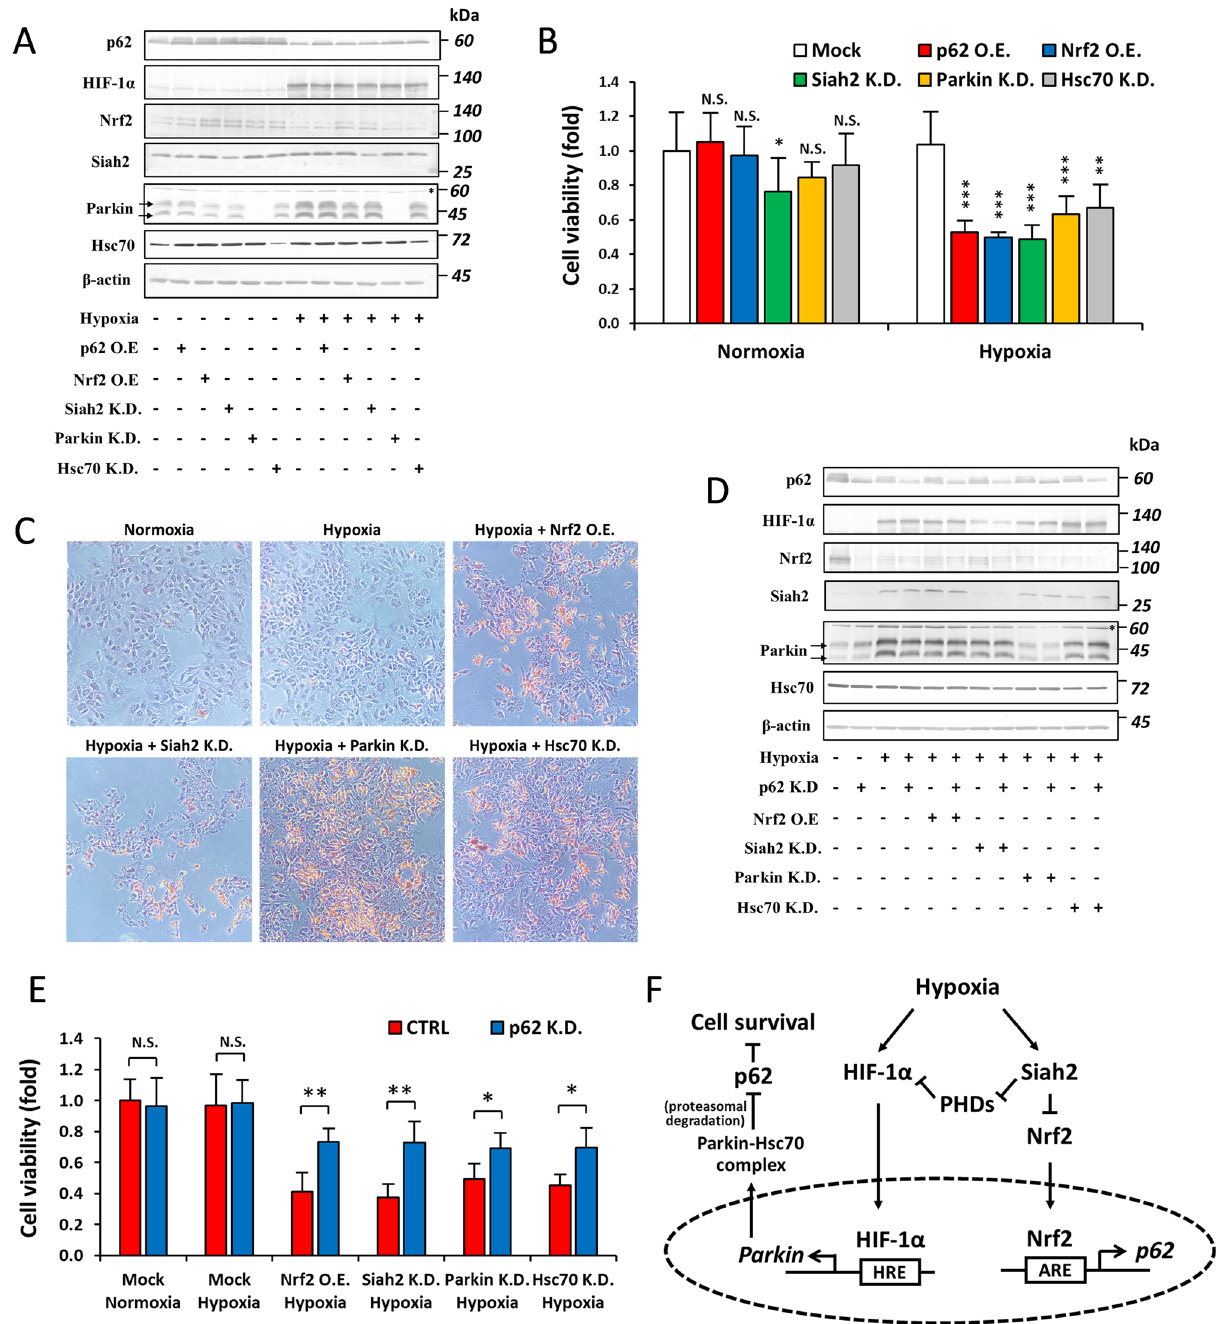
Figure 6. p62 depletion under hypoxia is essential for cell survival . ( A – C ) Hep3B cells were transfected with pcDNA-p62 (p62 O.E.), pcDNA-Nrf2 (Nrf2 O.E.), sh-RNA Siah2 (Siah2 K.D.), siRNA-Parkin (Parkin K.D.), or siRNA-Hsc70 (Hsc70 K.D.). Cells were then incubated under normoxia or hypoxia (O 2 = 1%) for 12 h. p62 protein levels ( A ), the viability of cells ( B ), and the number of apoptotic cells ( C ) were then assessed by immunoblotting, the MTT colorimetric assay, and colorimetric TUNEL assay, respectively. ( D and E ) Control and p62-knocked down Hep3B cells were transfected with pcDNA-Nrf2, sh-RNA Siah2, siRNA-Parkin, or siRNA-Hsc70 and then incubated under hypoxia (O 2 = 1%) for 12 h. p62 protein levels ( D ) and the viability of cells ( E ) were assessed by immunoblotting and the MTT colorimetric assay, respectively. ( F ) A working model describing the mechanisms responsible for the depletion of p62 under hypoxia involving transcriptional and post-transcriptional regulation by Nrf2 and Parkin-Hsc70,